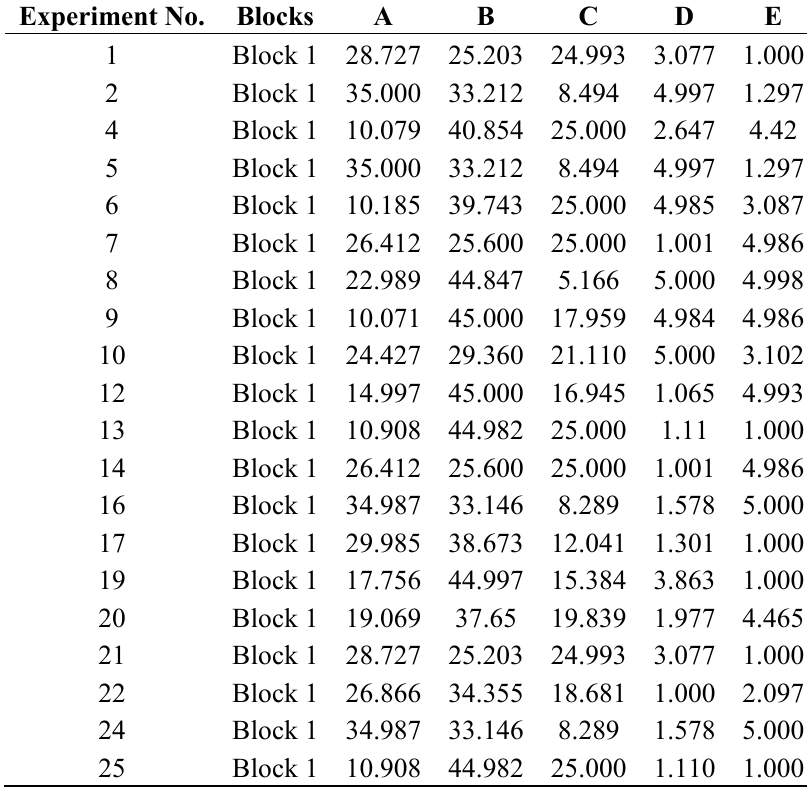
Table 6. The D-optimal design with 20 out of 25